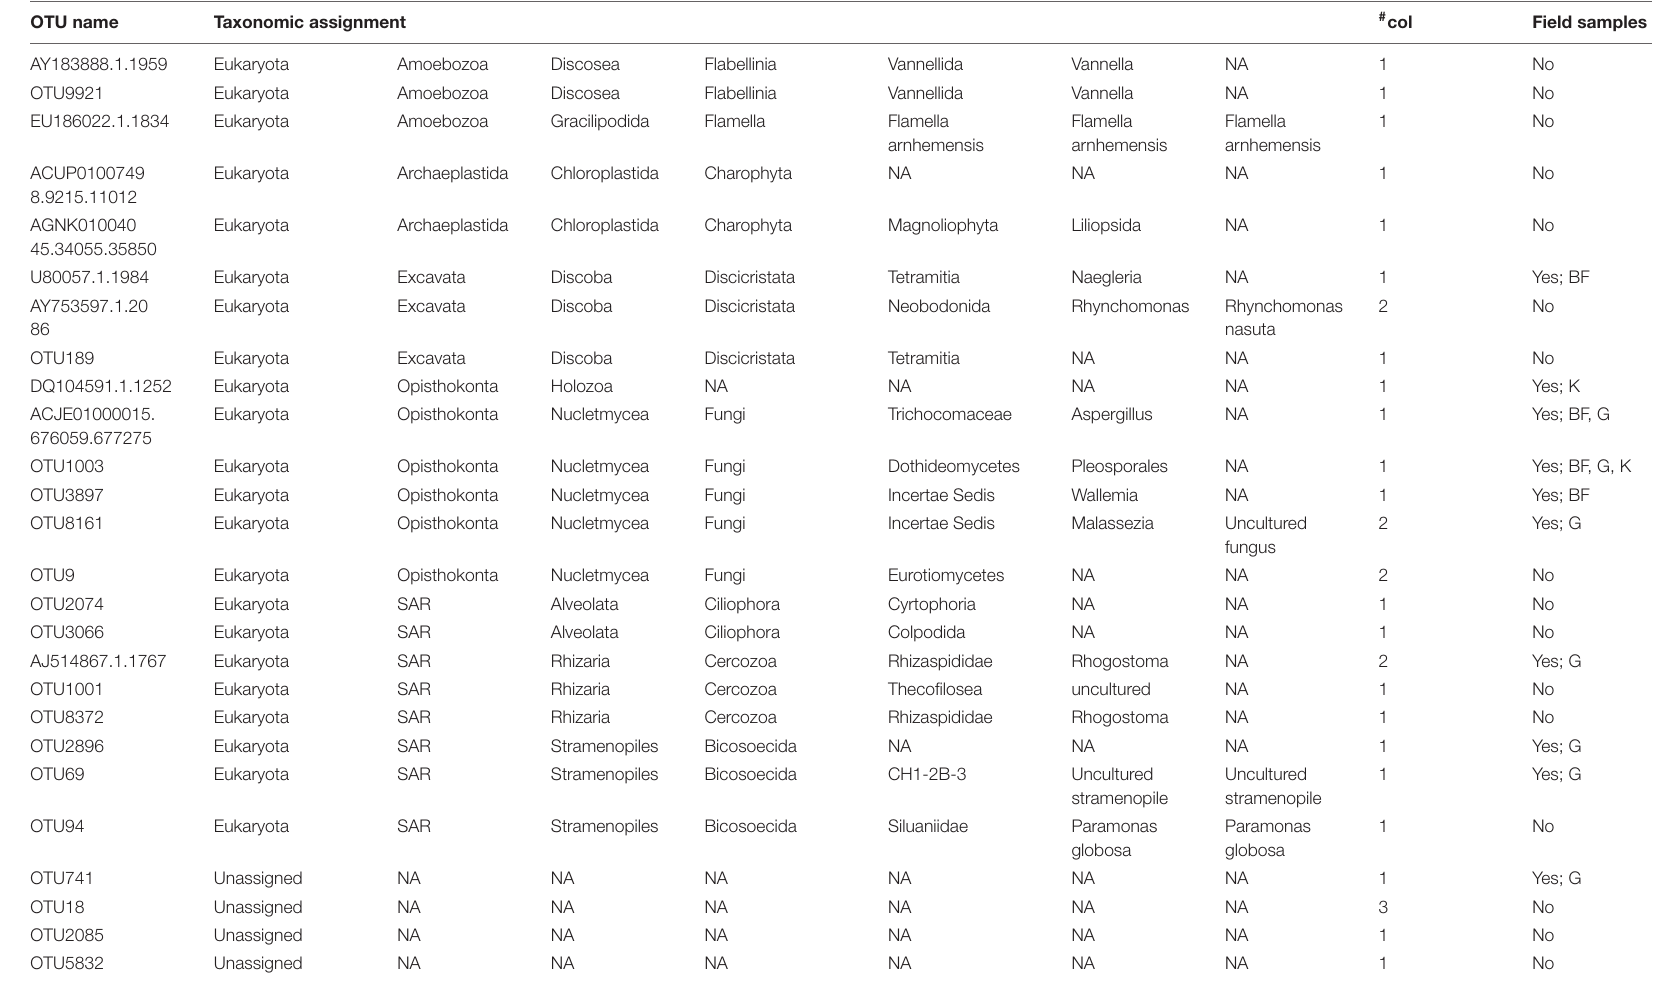
TABLE 1 | Eukaryotic OTUs in Anopheles laboratory